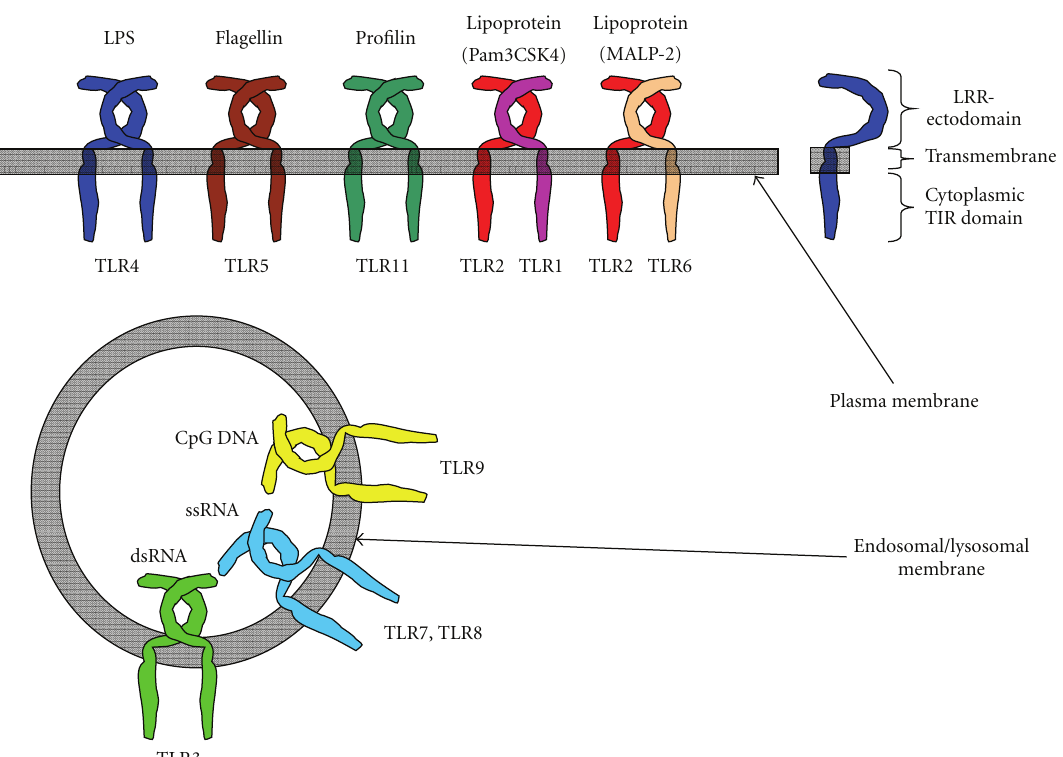
and TLR9 are intracellularly expressed in endosomal- or lysosomal-compartments and the endoplasmic reticulum